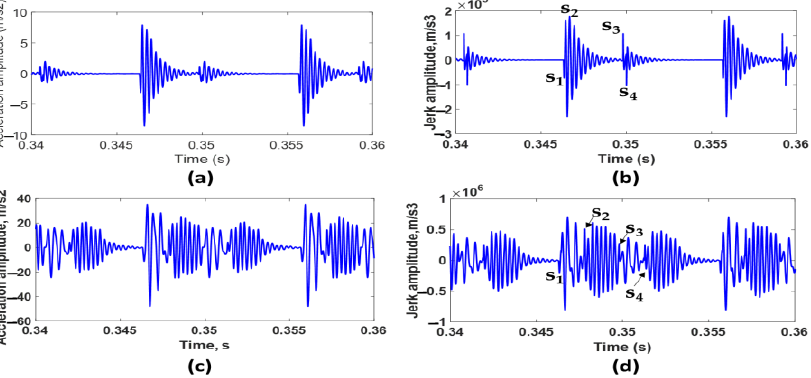
Figure 11. Dynamic response (acceleration and jerk) of a bearing has a bump and dent on its outer race with different widths ( a ) acceleration signals, and ( b ) jerk signals for 0.34 mm defect diameter; ( c ) acceleration signal and ( d ) jerk signal for 2.5 mm.